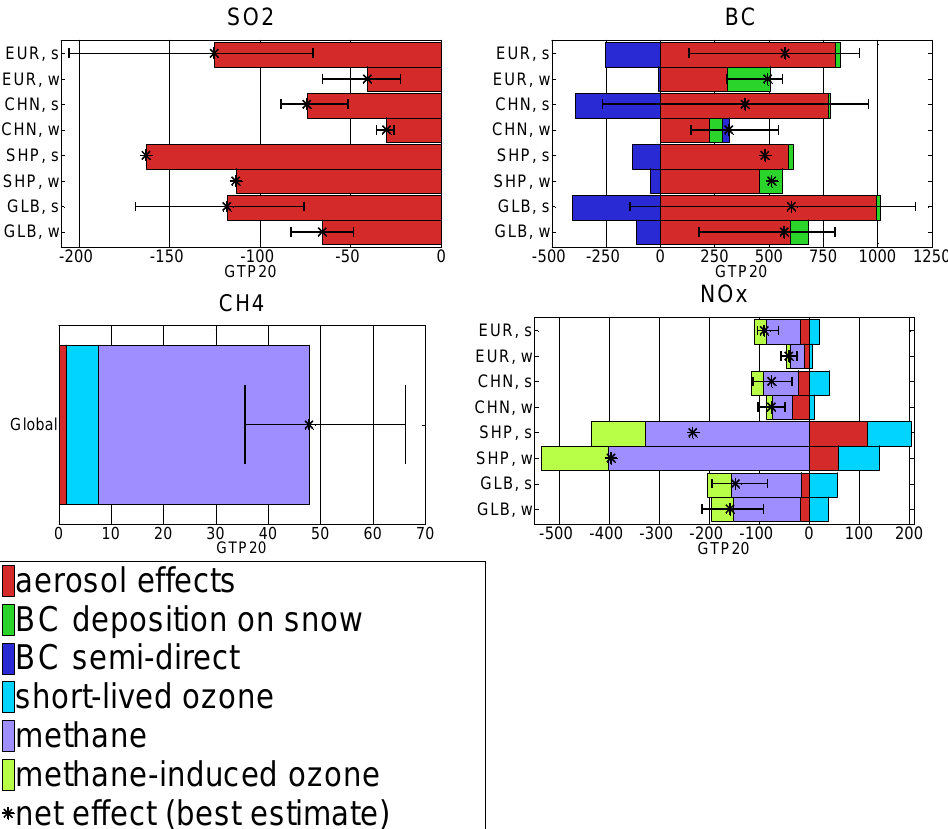
Figure 8. GTP 20 values for SLCPs, relative to an equal mass emission of CO 2 , for all regions and seasons, decomposed by processes and based on the RF values shown in Fig. 7. The regions included are Europe (EUR), China (CHN), global (GLB), and the shipping sector considered separately (SHP), all for both NH summer (s, May–October) and NH winter (w, November–April). Uncertainty bars reflect model spread. Only two models calculated effects of emissions from shipping and there no uncertainty range is